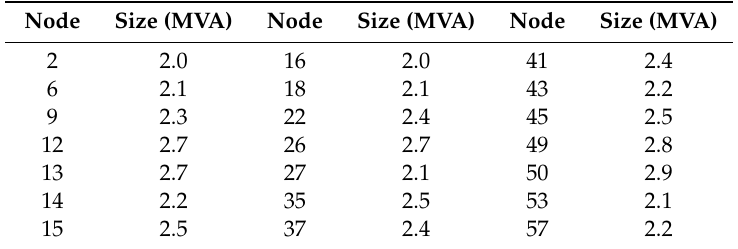
Table 4. Distributed generation (DG) nodes for 59-node distribution system.